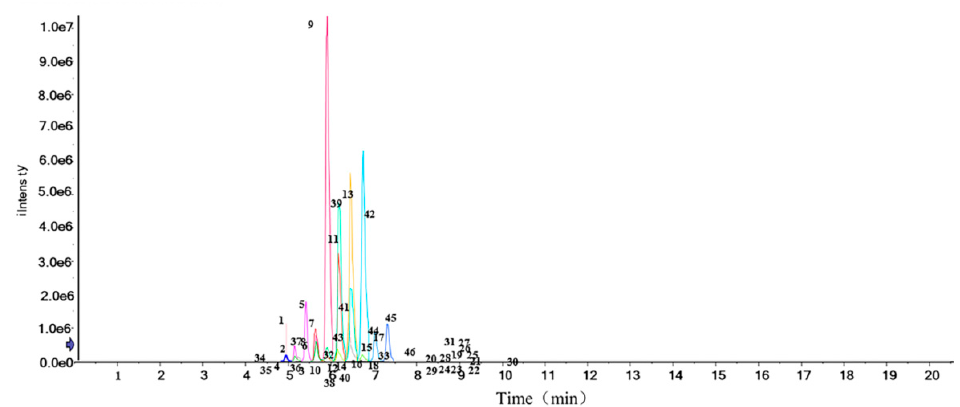
Figure 6. Ion chromatogram for the identification of total Cers in sea red rice bran by UHPLC-Triple-TOF-MS/MS.